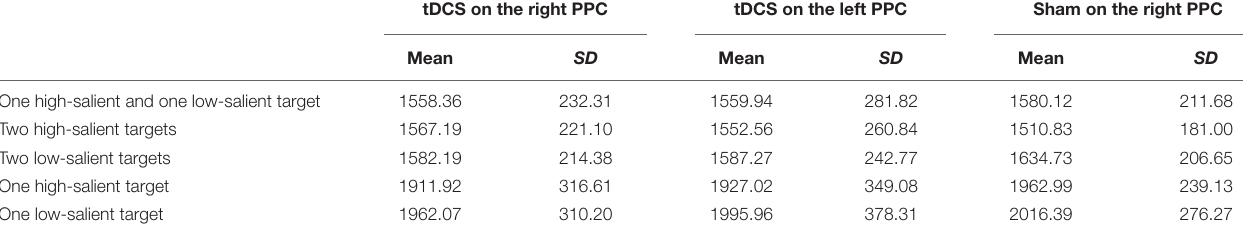
resources, and increasing the magnitude of SSM effect. Indeed resource depletion may still occur, but no attentional resources fall under depletion as expected. Still, WM resources are